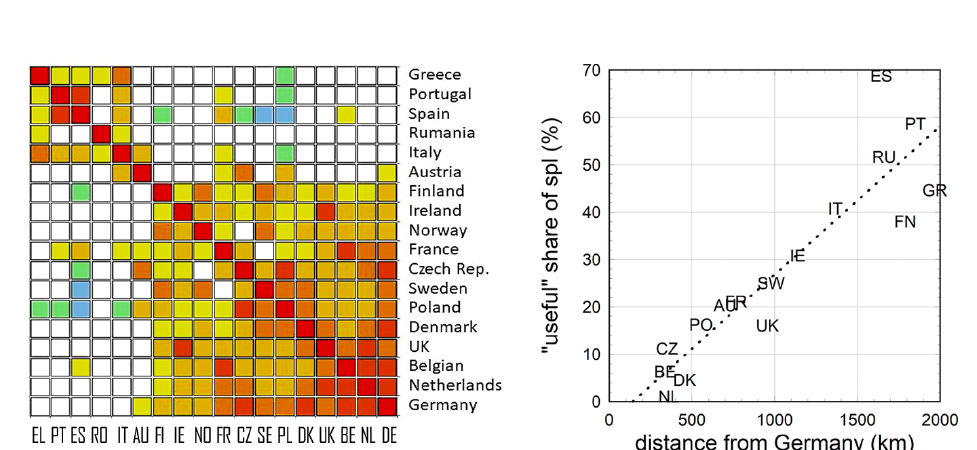
Fig. 11. – Left: Spaerman correlation matrix of onshore wind energy between the countries listed (2016). Wind generation is correlated in two well separated areas. Apart from autocorrelation, the correlation coefficients vary from reddish (0.8) to yellow (0.25). Only a small correlation exists between the southern and northern countries. Right: the “useful” share of a country’s surplus is plotted against the distance of the wind park core of this country from Germany’s wind park core (see text). “Useful” is defined as surplus energy of a country at a moment when Germany actually needs